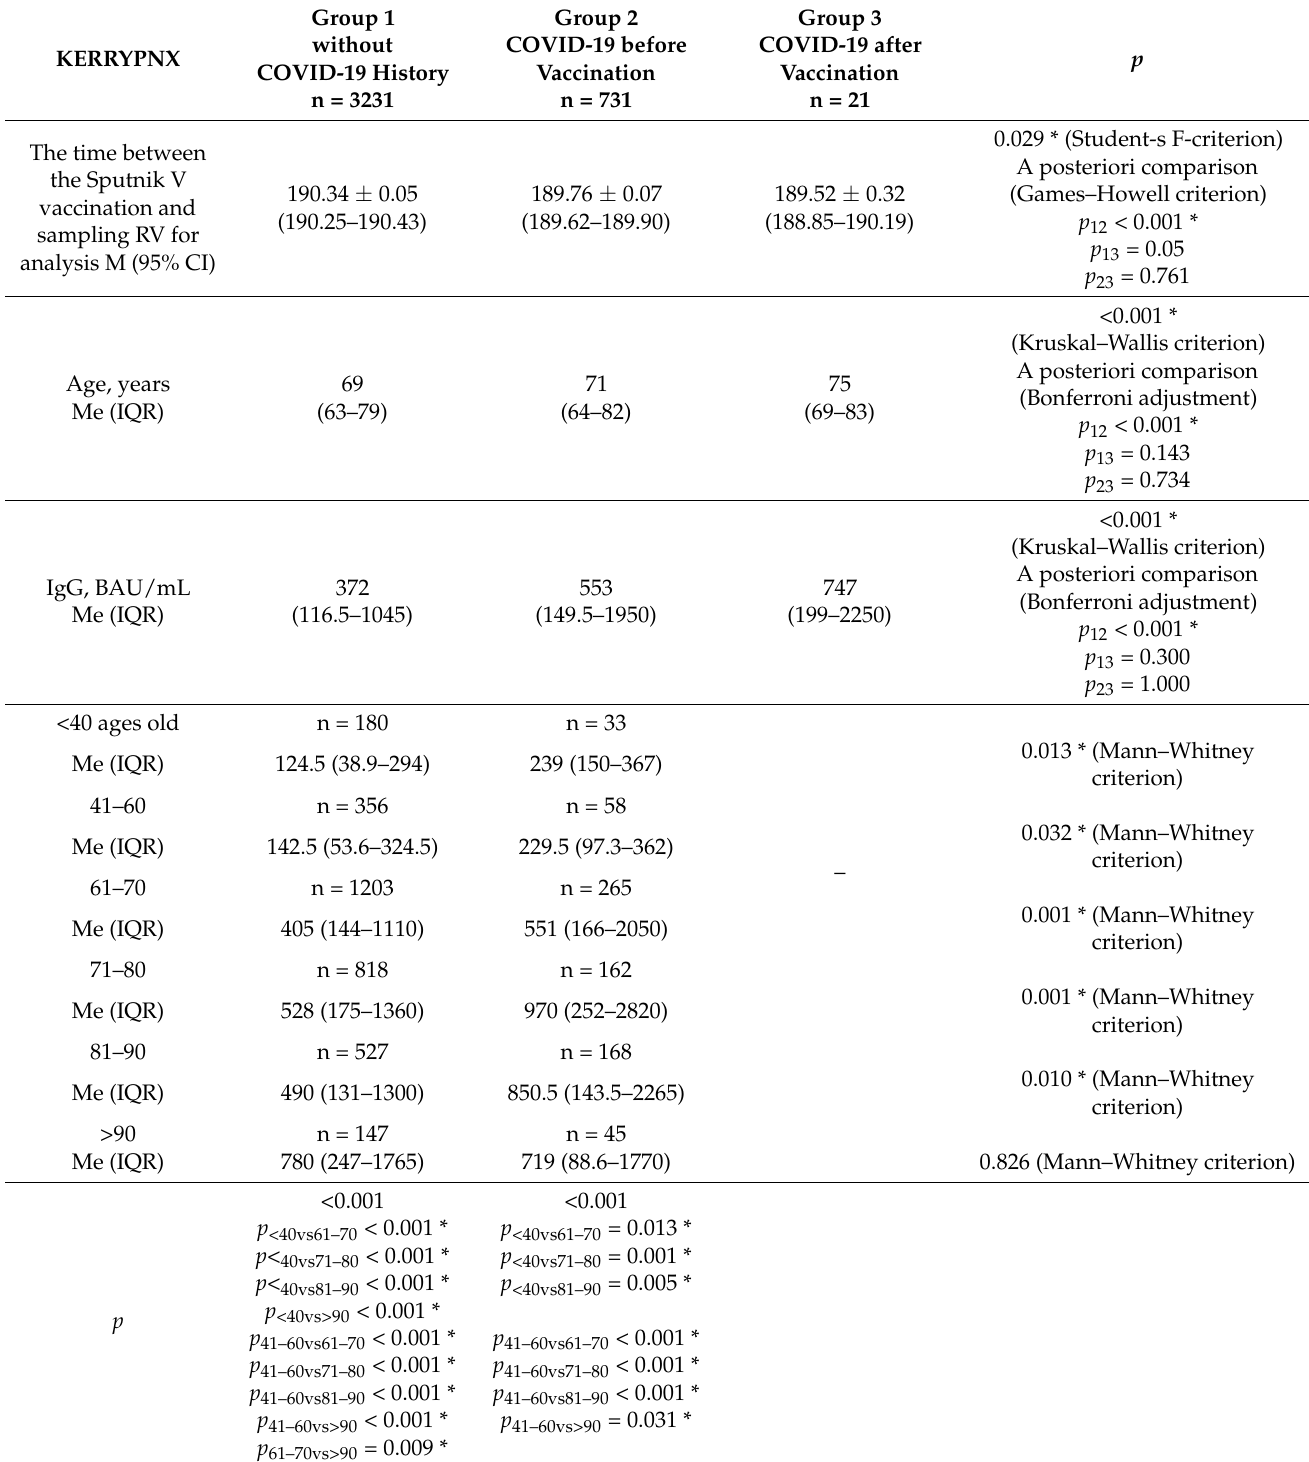
Table 1. Demographic description and the level of IgG to RBD six months after